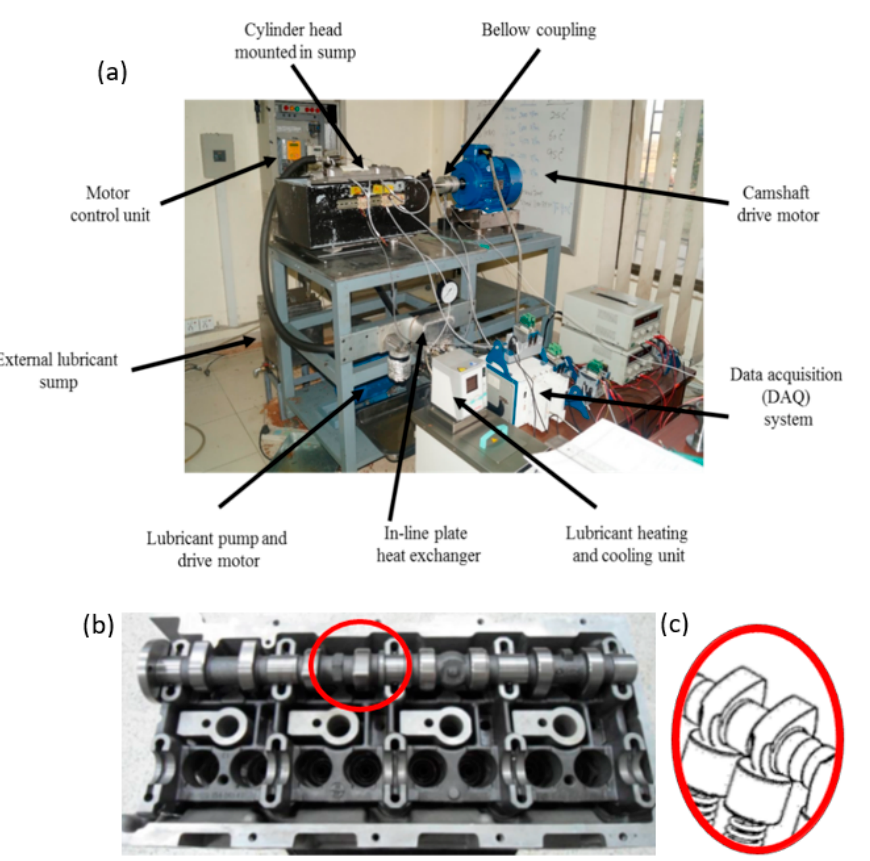
Figure 2. ( a ) Direct acting valve train test rig; ( b ) Mercedes Benz OM646LA cylinder head; ( c ) cam/tappet interface.